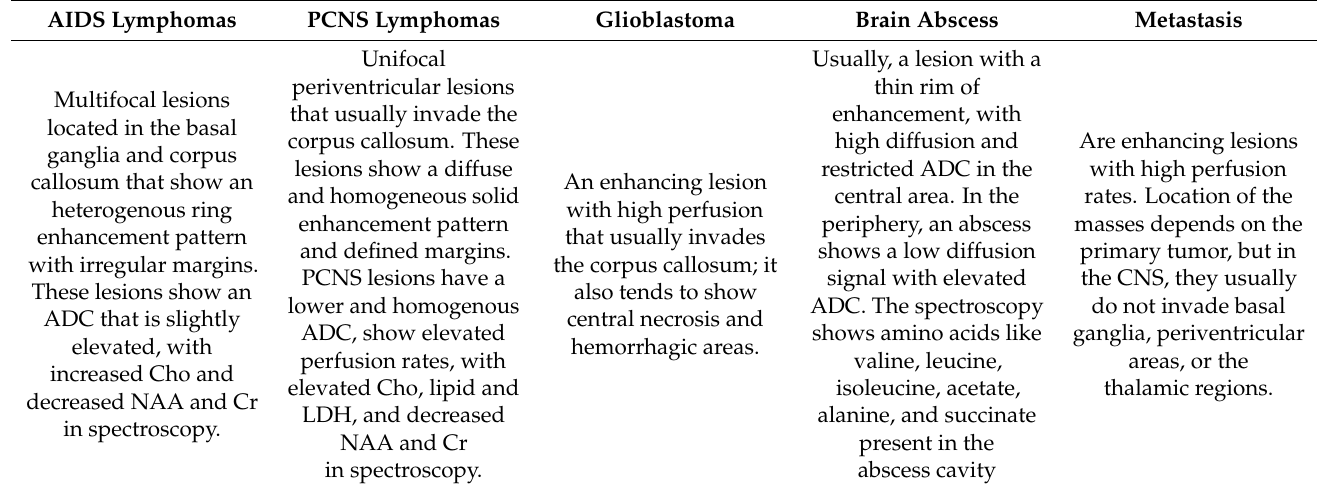
Table 2. Differential features of pathologies that resemble